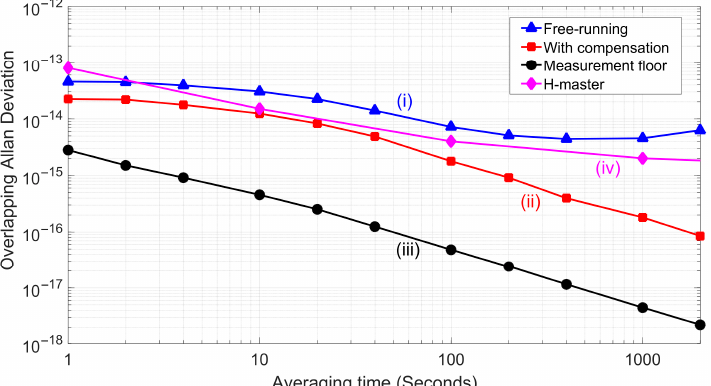
Figure 5. Frequency instability results for the fiber-based RF transfer. (i) Free-running link without phase compensation. (ii) With optical–electronic joint phase compensation. (iii) The measurement floor for the short link. (iv) For H-master clock.